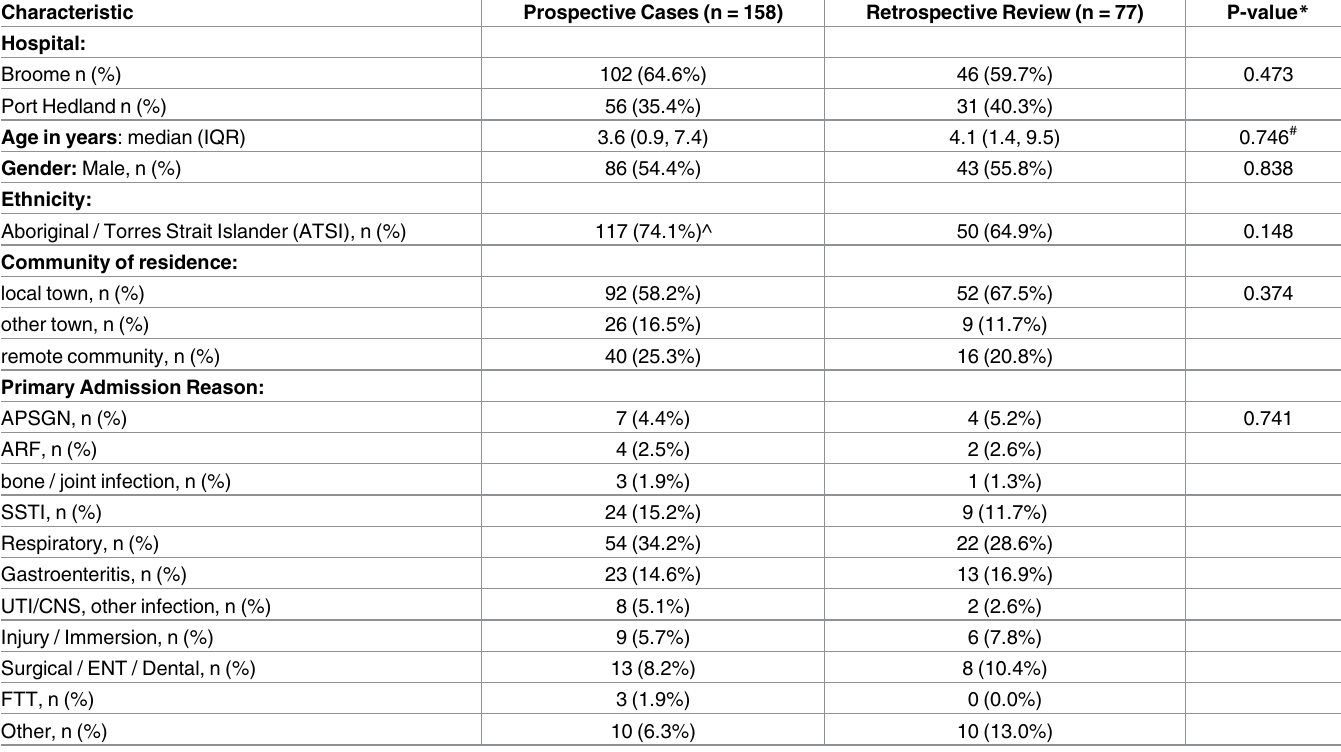
Table 1. Baseline characteristics–prospective vs retrospective.